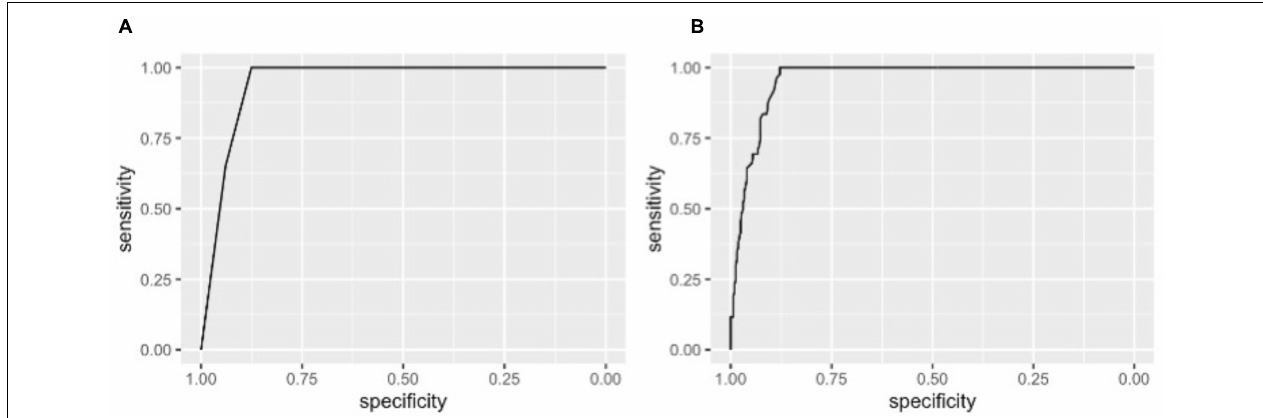
FIGURE 3 | Receiver operating characteristic (ROC) curves for improvement in CFC by ≥ 2 categories following PCI. The ROC curves showing the discrimination of CFC improvement by ≥ 2 categories by pre-PCI CFC alone (A) and CFC plus FFR (B) . Area under the curves ( AUCs ) (95% CI ) were 0.95 (0.93, 0.97) and 0.96 (0.94, 0.98) in panels (A,B) , respectively. Note, at the best cutoffs, the specificity was 100% because such improvement could only be observed in patients with pre-PCI severely or moderately reduced CFC.